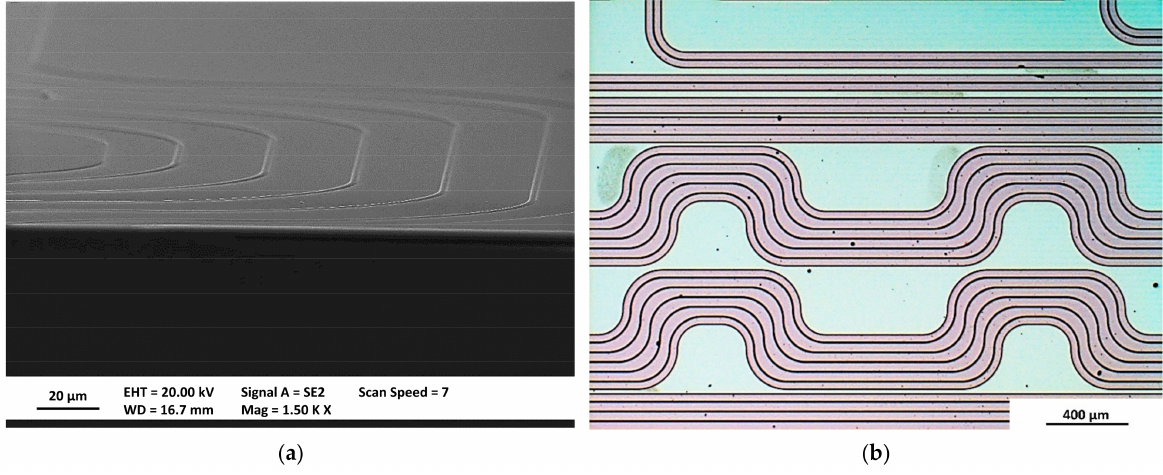
Figure 15. Scanning electron microscopy (SEM) ( a ) and optical ( b ) microscopic images of manufac- tured